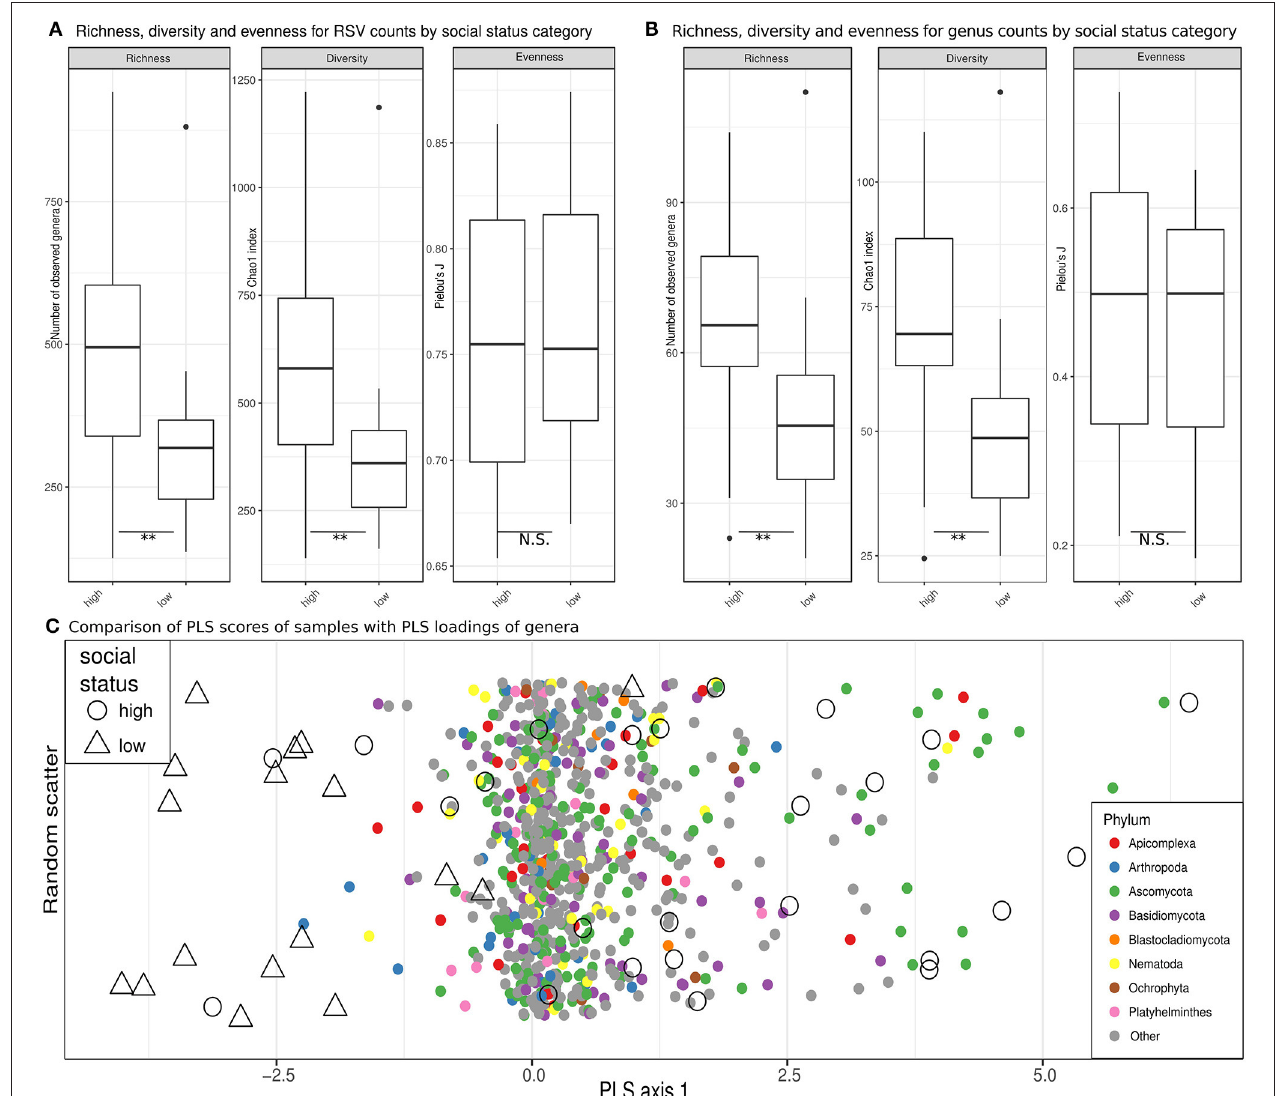
FIGURE 4 | Eukaryome diversity and composition in high ranking vs. low ranking hyenas. (A) Estimates of richness (observed counts of genera richness per phylum), diversity (Chao1 index) and evenness (Pielou’s J ) on rarefied (see methods) ribosomal sequence variant (RSV) counts for high-ranking and low-ranking individuals. (B) Counts for annotated RSV per genus are compared in box plots for high and low ranking hyenas. **Significant differences ( p < 0.01) based on exact Mann-Whitney U tests. (C) A comparison of PLS scores (for samples) and PLS loadings (for genera) are visualized on the single PLS axis of an optimized partial least squares model, demonstrating a separation of the majority of samples from high-ranking individuals from samples from low-ranking animals. On the y-axis random scatter is introduced for visualization. The underlying genera are color-coded for their respective